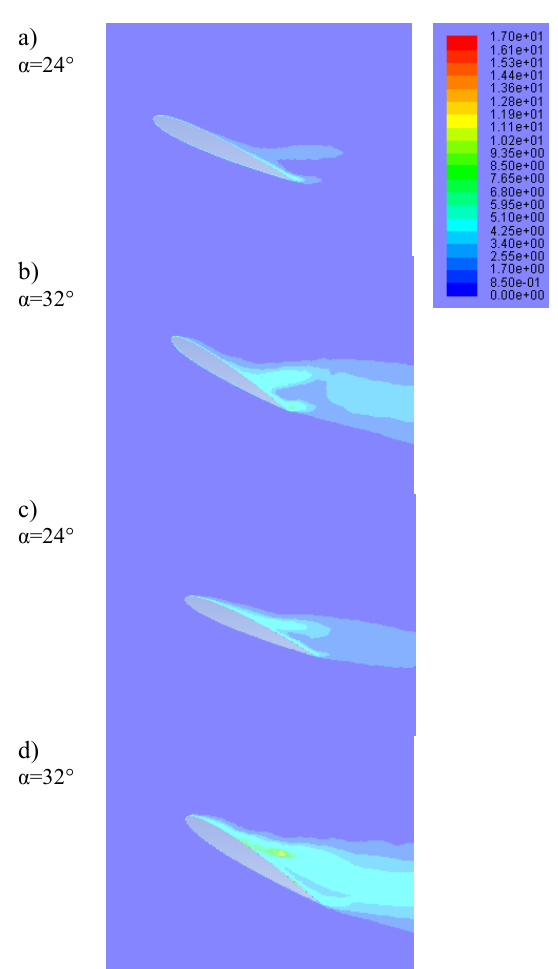
Fig. 7. The turbulence kinetic energy contours over the wings in the middle plane at α =24 ° and α =32 ° with Transition SST model for rigid wing (a-b) and for tubercle wing (c-d)